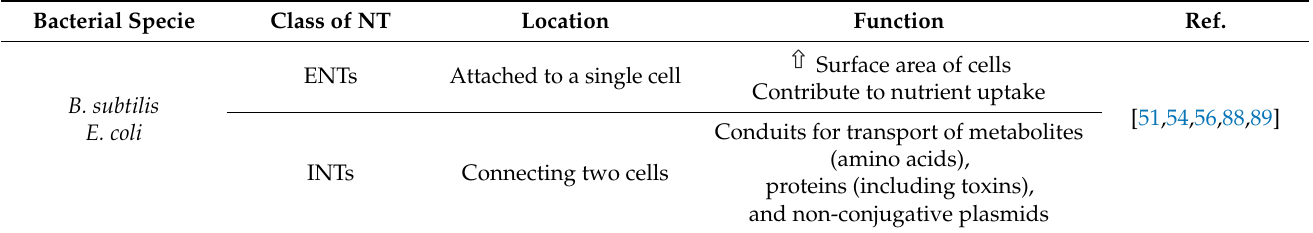
Table 4. Classes and functions of NTs in B. subtilis .